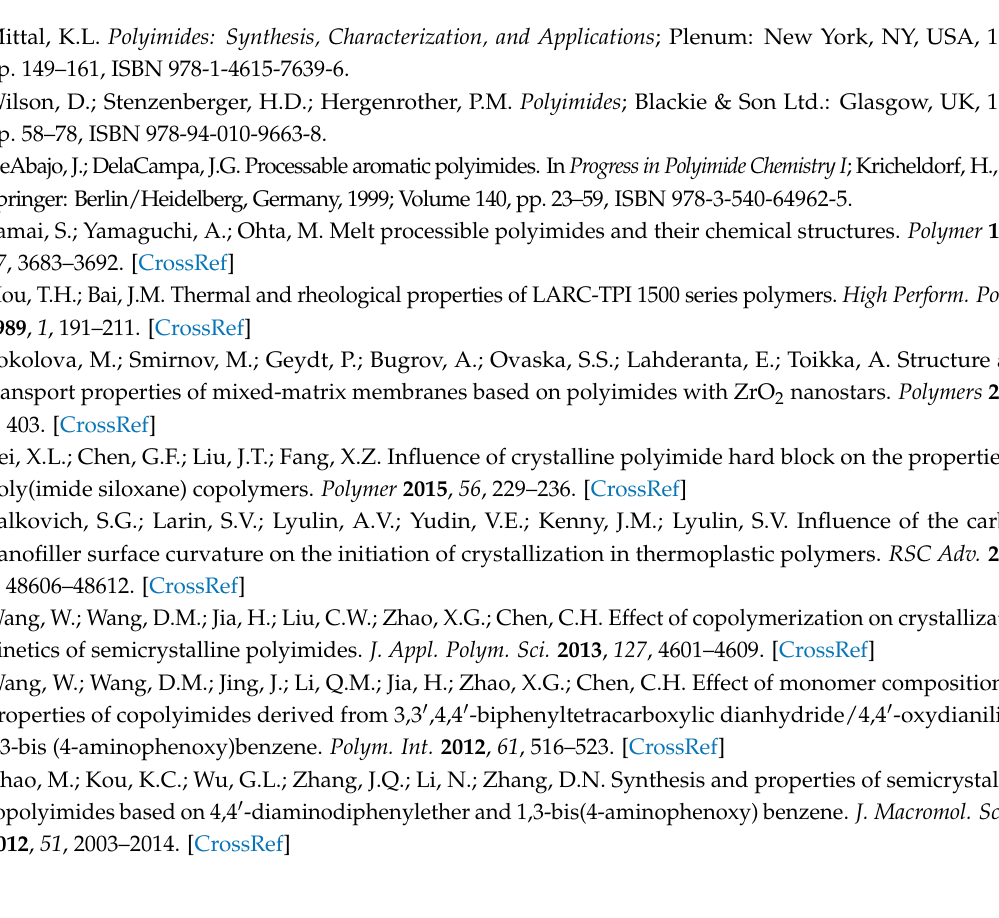
Figure S1: FTIR spectra of polyimides. Figure S2: DSC curves of PI-1 after different isothermal treatment. Figure S3: WAXD patterns of PI-1 after different isothermal treatment. Figure S4: Hoffman-Weeks plot for PI-1 and PI-2. Figure S5: Normalized crystalline content as a function of time at various crystallization temperatures. (a) PI-1, (b) PI-2. Figure S6: Avrami plot of log [ − ln (1- X c ( t ))] versus log t at various crystallization temperatures. (a) PI-1, (b)